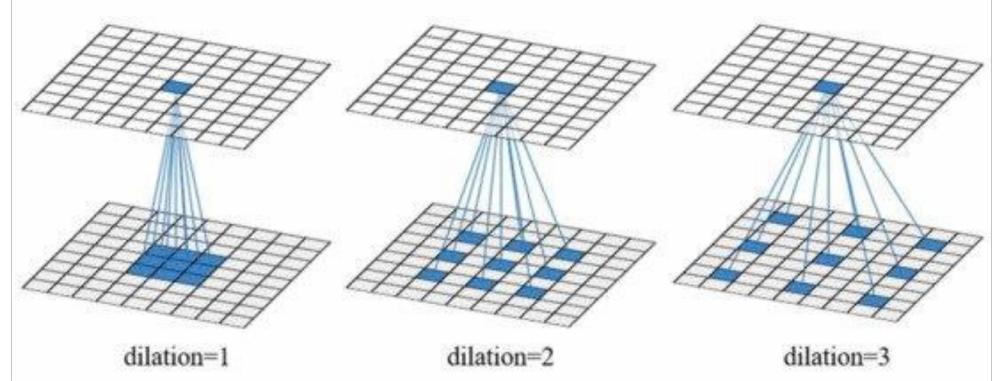
Figure 3. Expansion rate impact on convolutional filters [41].